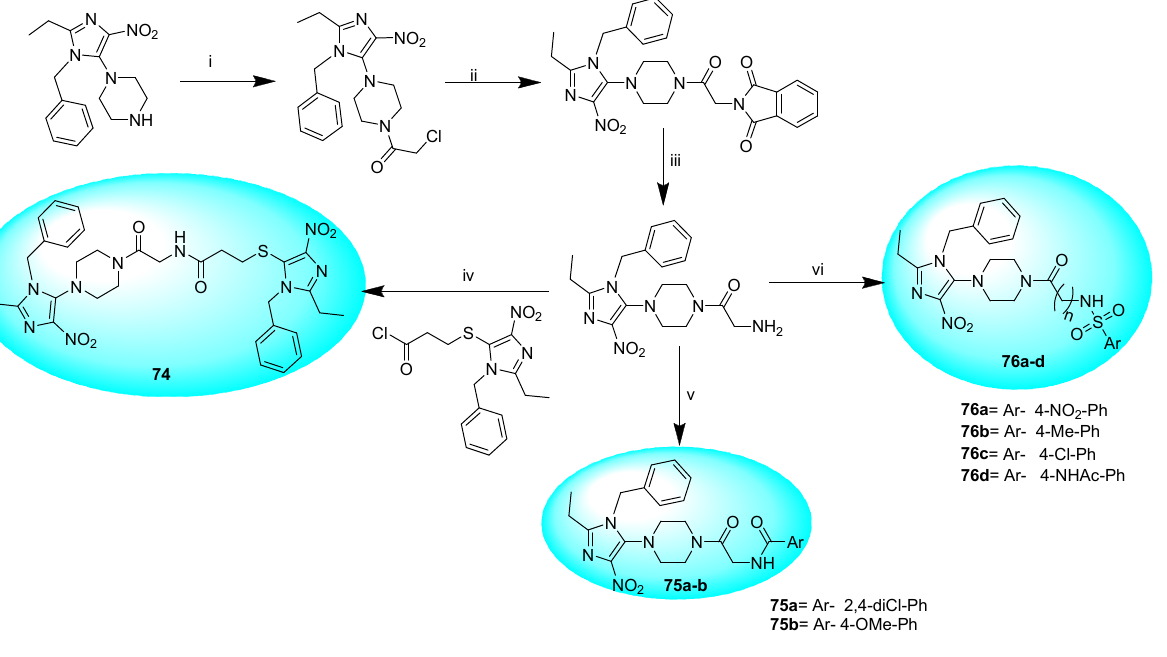
Scheme 21. Synthetic pathway of [(4-nitro-1 H -imidazol-5-yl)piperzin-1-yl)2-oxoethyl]aryl/alkyl-sulphonamide and benzamide derivatives as anti-HIV agents. Reagents and conditions: ( i ) 2-chloroacetyl chloride, Et 3 N, CH 2 Cl 2 , 23 °C, 3 h (yield not reported); ( ii ) potassium phthalimide, DMF, 120–130 °C, 24 h (yield not reported); ( iii ) NH 2 NH 2 .H 2 O, reflux, 4 h, 78%; ( iv ) Et 3 N, CH 2 Cl 2 , 23 °C, 16 h, 43%; ( v ) ArCOCl, Et 3 N, CH 2 Cl 2 , 23 °C, 16 h, 54% and 47%; ( vi ) RSO 2 Cl, Et 3 N, CH 2 Cl 2 , 23 °C, 16 h, 39–47%. Al-Soud et al. (2007) designed and synthesized the new 5-alkylsulfanyl and 5-(4-arylsulfonyl)piperazinyl-4-nitroimidazole-based derivatives 77 and 78 , respectively, as anti-HIV agents (Scheme 22). In this, the authors synthesized 15 new derivatives evaluated against HIV-1, and among them, two molecules 77e and 77g showed better EC 50 inhibitions and a better safety index [91]. Lee et al. (2011) designed and synthesized econazole-based nitroimidazoles analogs ( 79 – 82 ) and evaluated them for antitubercular activity. The introduction of a nitro group at the 4-position of the imidazole of econazole abolished the anti-tubercular (Scheme 23)